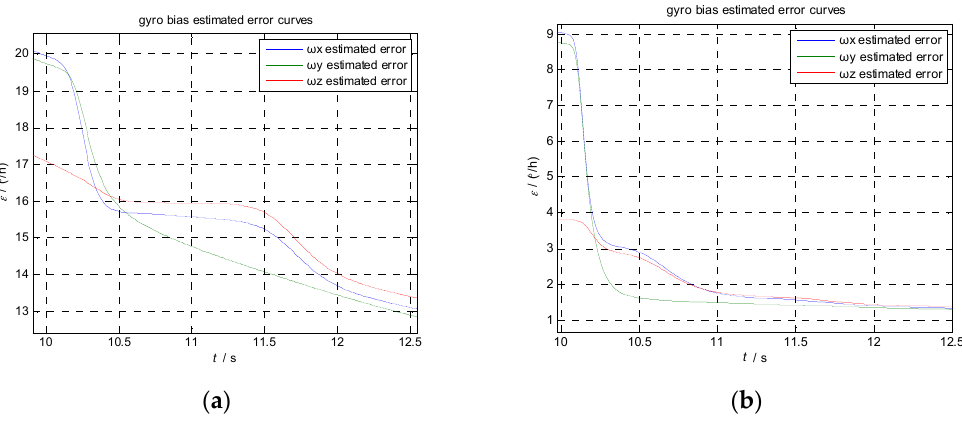
Figure 6. Part of the estimation error result using KF and AIKF. ( a ) Estimation error of gyroscope bias using KF; ( b ) Estimation error of gyroscope bias using AIK. Table 3. Bias estimation result of two algorithms.